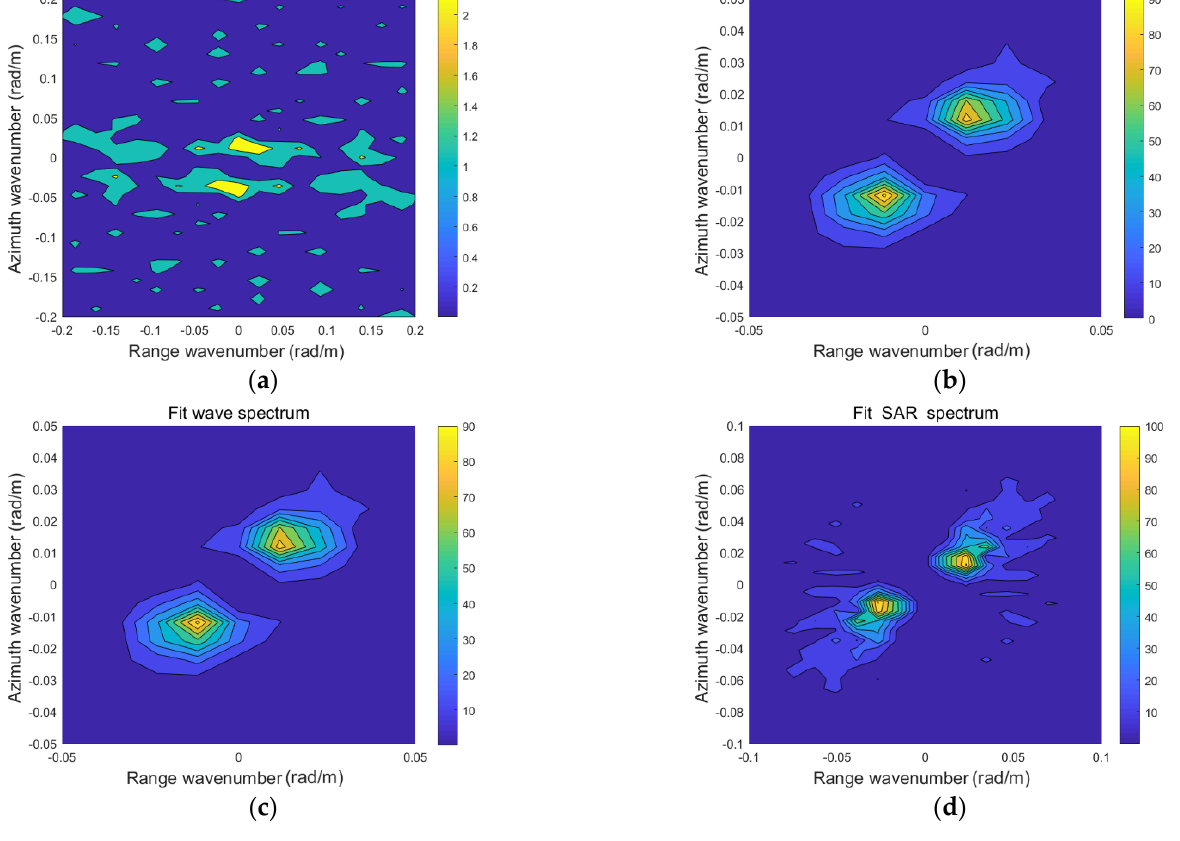
Figure 5. Wave spectrum inversion results in 256 × 256 pixels: ( a ) Observation of SAR spectrum; ( b ) First-guess spectrum; ( c ) Fit wave spectrum; ( d ) Fit SAR spectrum.